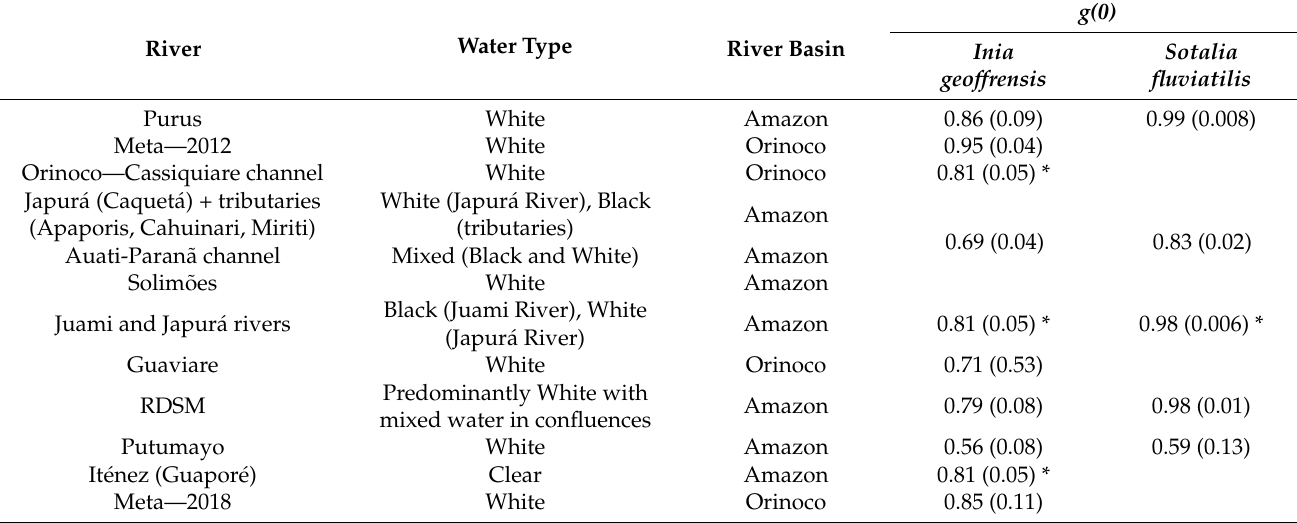
Table 3. Estimated survey-specific detection probability of seeing a group of dolphins at zero distance from the trackline ( g(0)